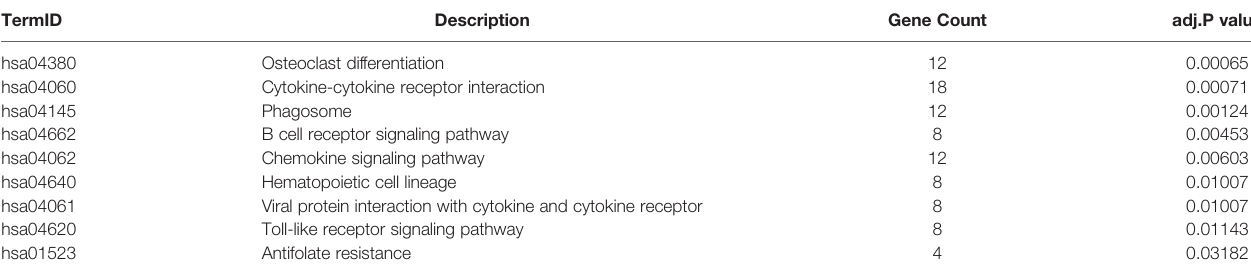
TABLE 2 | KEGG enrichment analysis results of the TME-related DEmRNAs.